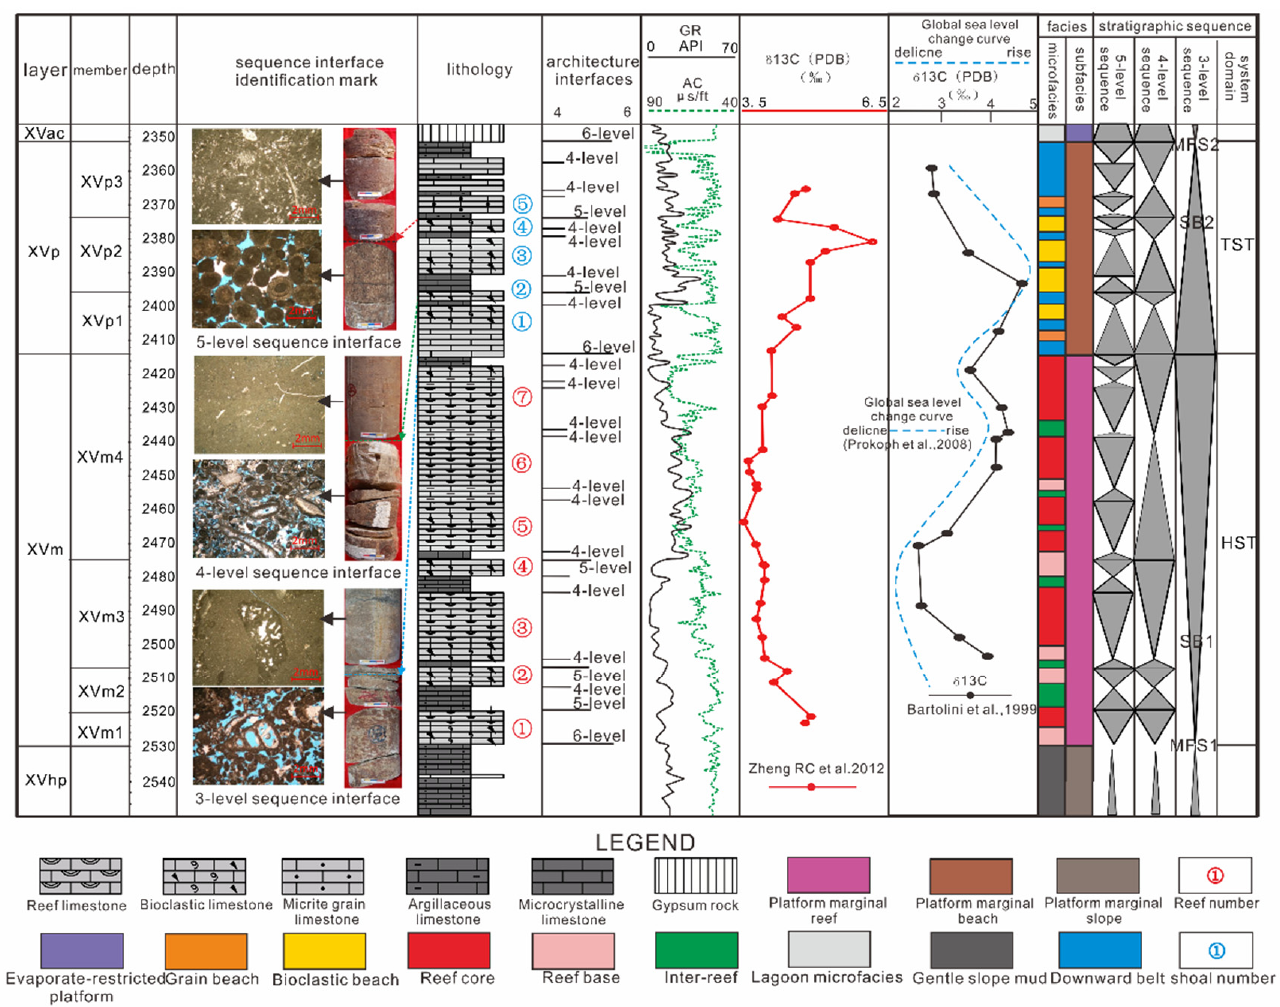
Figure 3. Comprehensive identification of reef and shoal facies depositional architecture interface in XVp and XVm lagers of S-53-1 well.